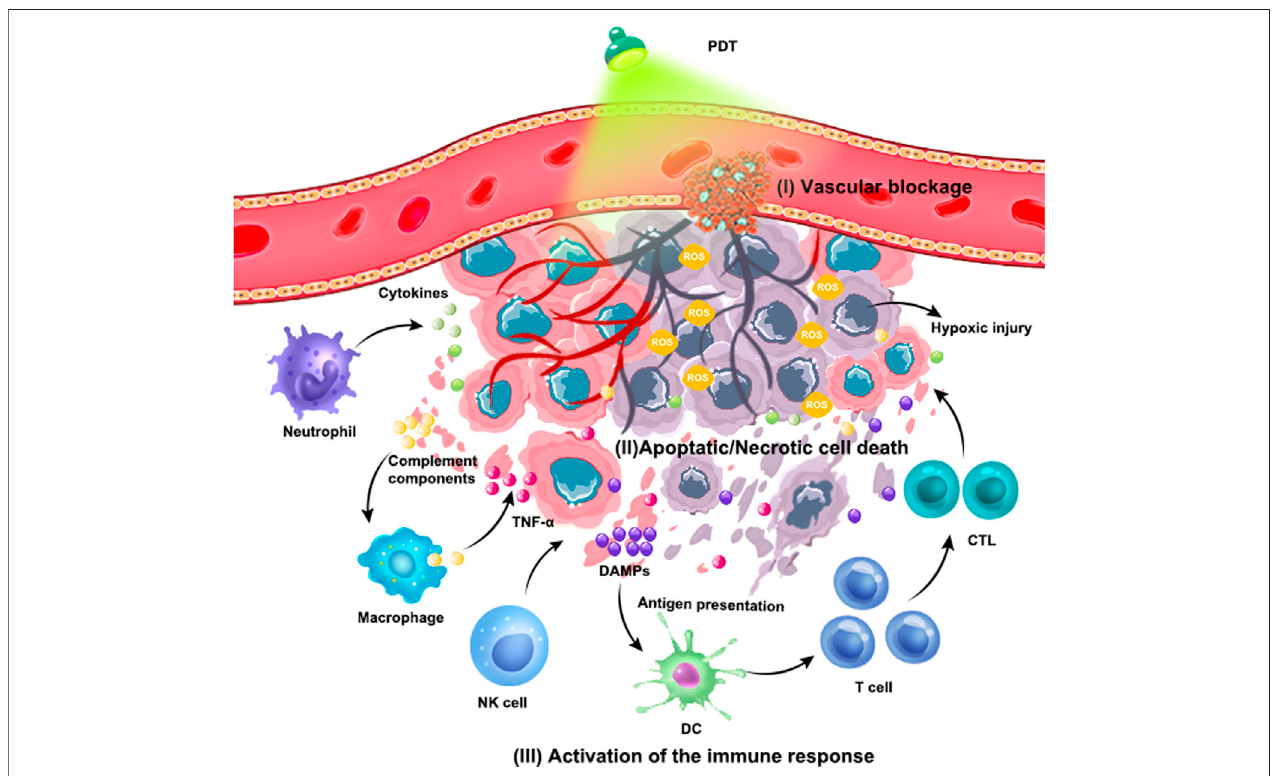
FIGURE 1 | Schematic illustration of the antitumor mechanism of